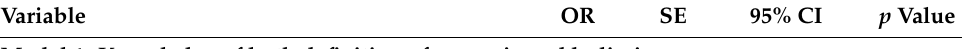
Table 3. Multivariate logistic regression model indicating associations between independent variables and the outcomes of